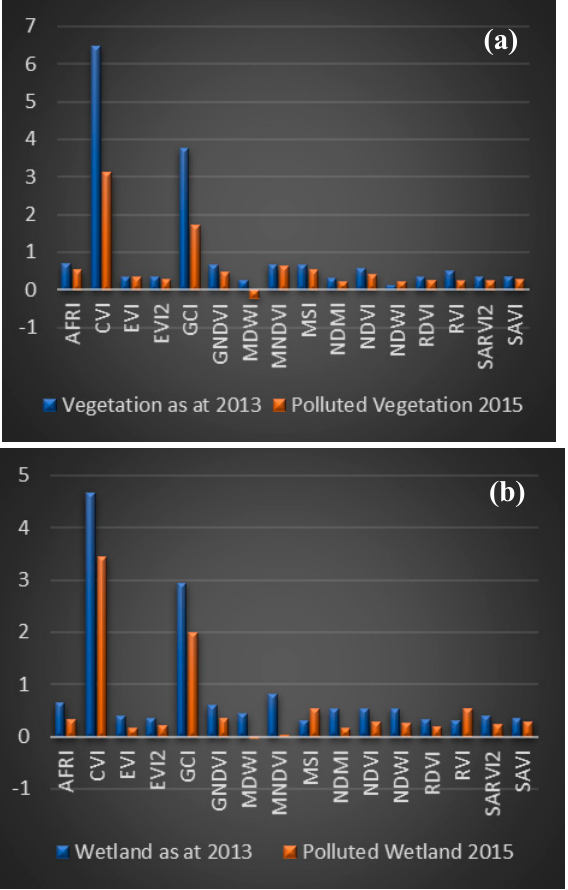
Figure 5. ( a ) Vegetation before and after pollution; ( b ) wetland before and after pollution.